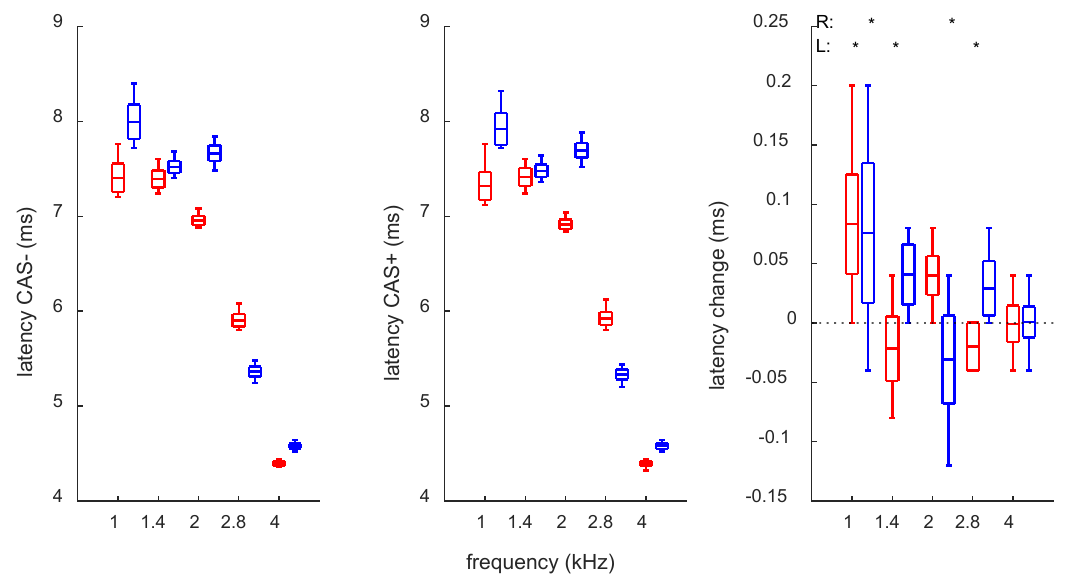
Figure 3. Average latency for TEOAEs and MOCR induced latency change. * Asterisks in the right plot mark significant differences from zero. All other descriptions as in Figure 1.